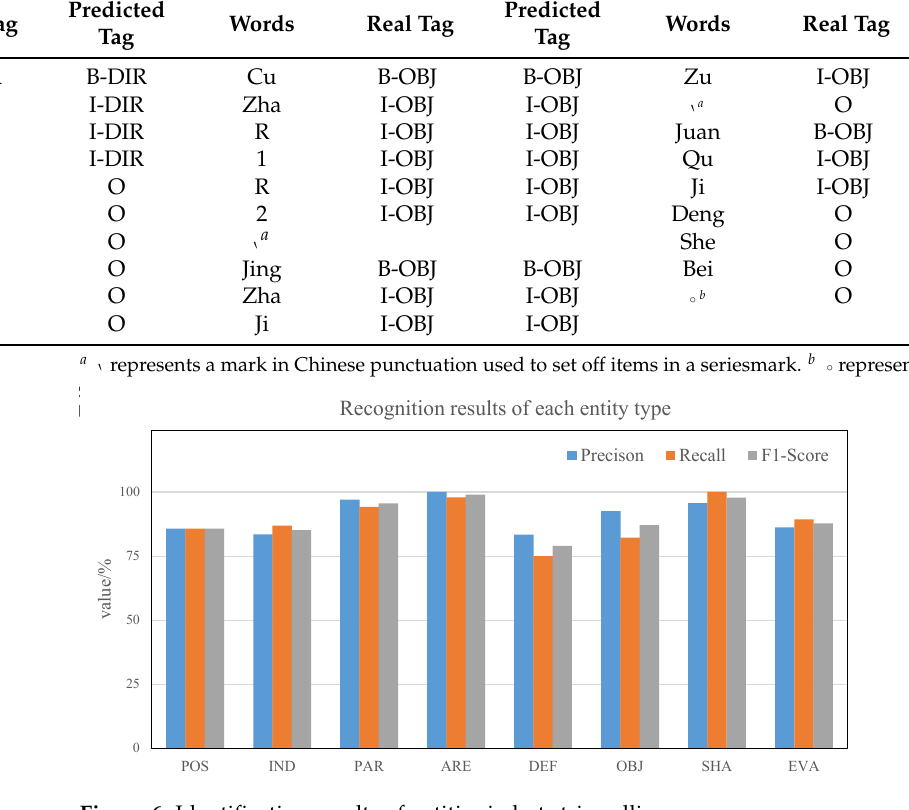
Figure 6. Identification results of entities in hot strip